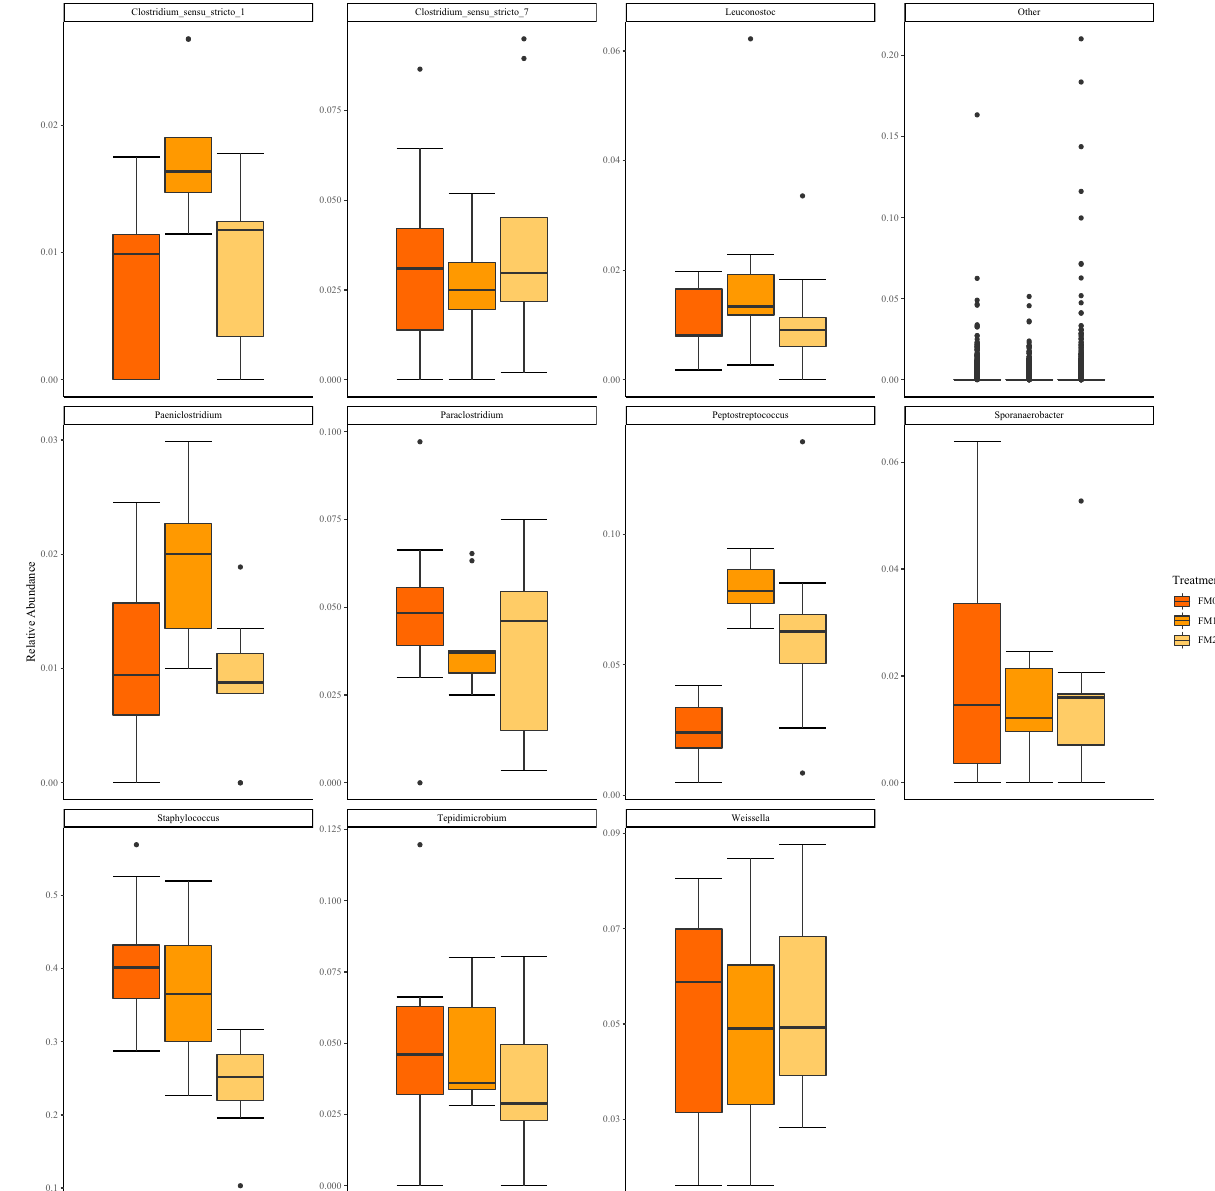
Figure 6. Boxplots of gut bacterial composition using relative abundance of the most common genera for FM